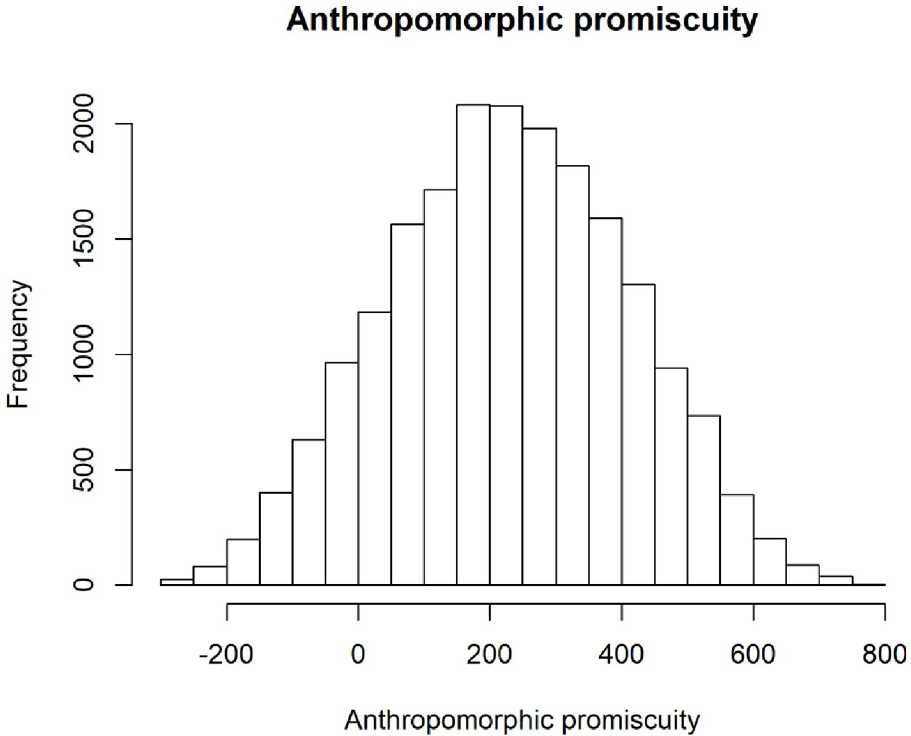
Fig 20. Distribution of anthropomorphic promiscuity outputs from the simulation